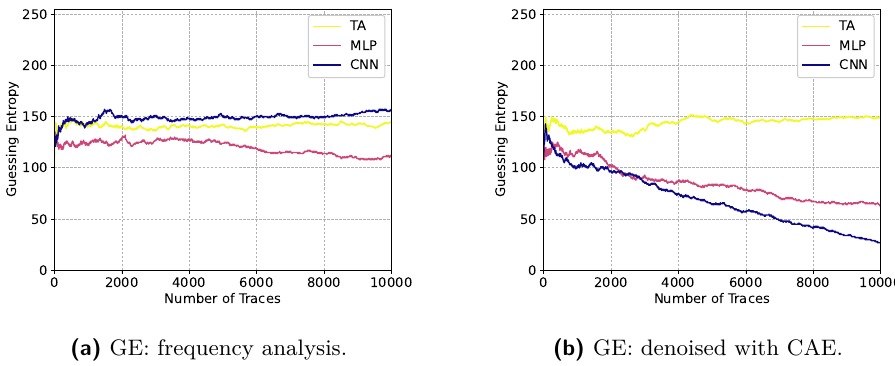
Figure 11: Guessing entropy: denoising combined noise with frequency analysis (a) and CAE